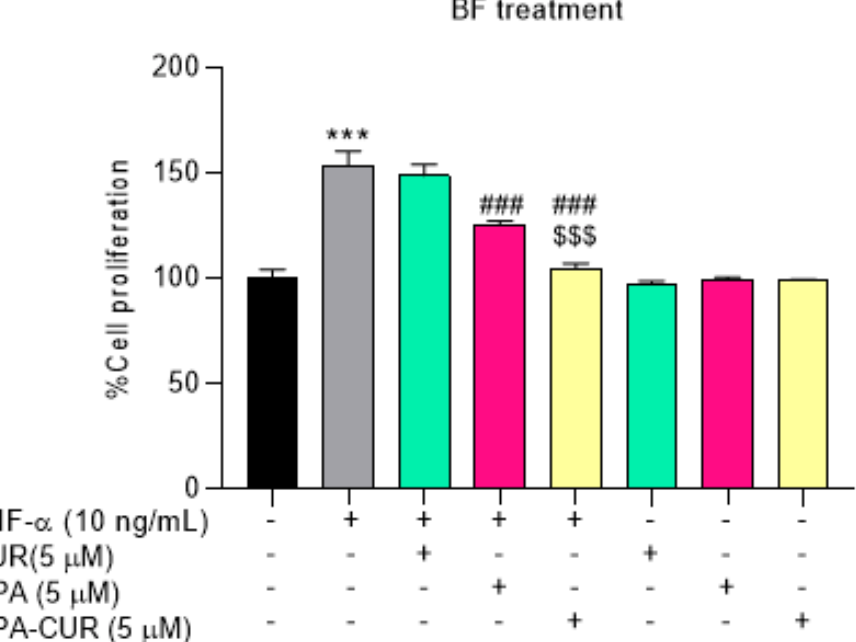
Figure 5. Cell proliferation of TNF- α -induced HaCaT cells incubated with MPA, CUR, and MPA- CUR for 24 h in BF treatment. Data presented are mean ± SD values of three replicates *** p < 0.001 indicates significance from the untreated control cells, ### p < 0.001 indicates significance from TNF- α control group and $$$ p < 0.001 indicates significance from CUR and MPA treated groups.